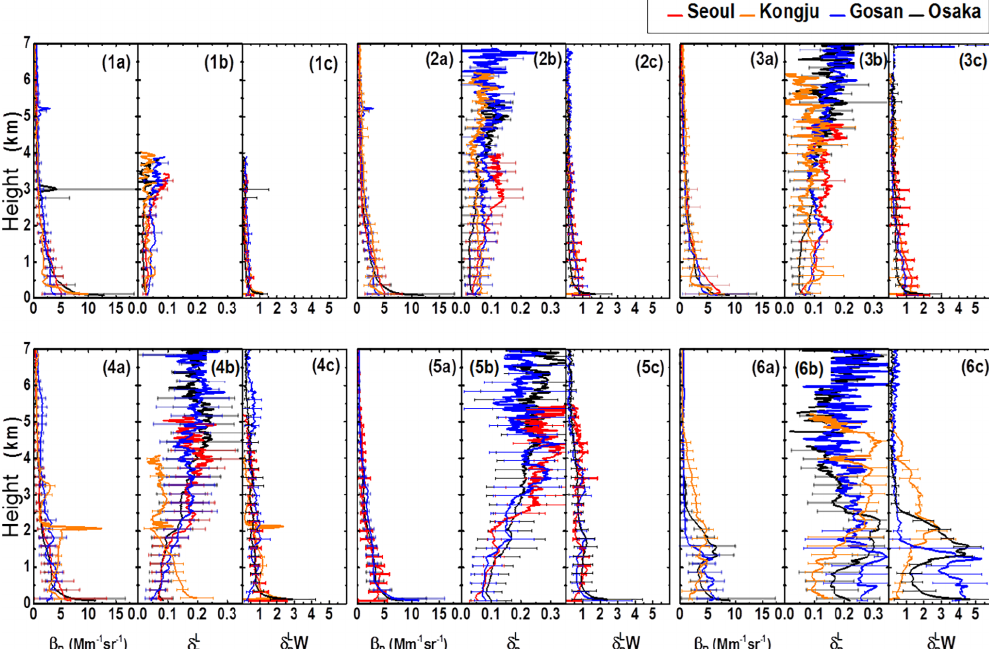
Figure 8. Average values of the vertical profiles of (a) the particle backscatter coefficient, (b) the linear particle depolarization ratios ( δ L and (c) the weighted linear particle depolarization ratios ( δ LW group 6 (6). The sites are Seoul (red), Kongju (orange), Gosan (blue), and Osaka (black).